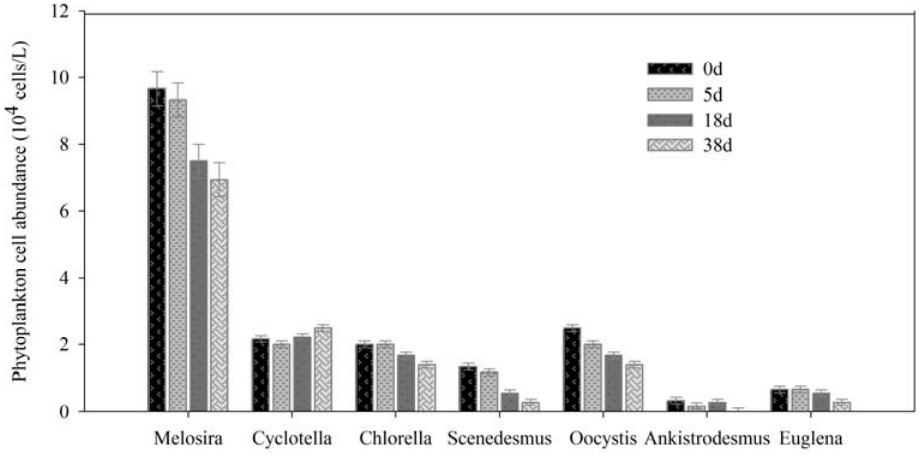
Figure 1. Variations of phytoplankton cell abundance (phylum).